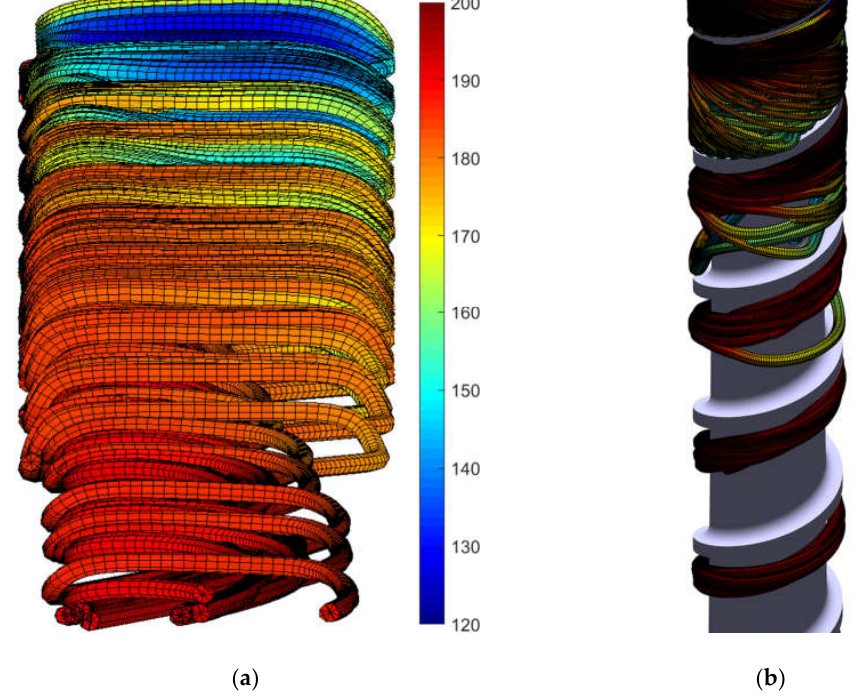
Figure 9. ( a ) Streamlines for melt flows in screw channels starting at turn 13 of the general purpose screw. The length of the streamline is related to the residence time; only eight of the 100 starting particles exit the melt channel after 50,000 iterations with a step size of 0.04 mm; ( b ) Visualized streamlines placed on the screw for turns 18 to 22 with coiling of the recirculating flow in the melt pool.